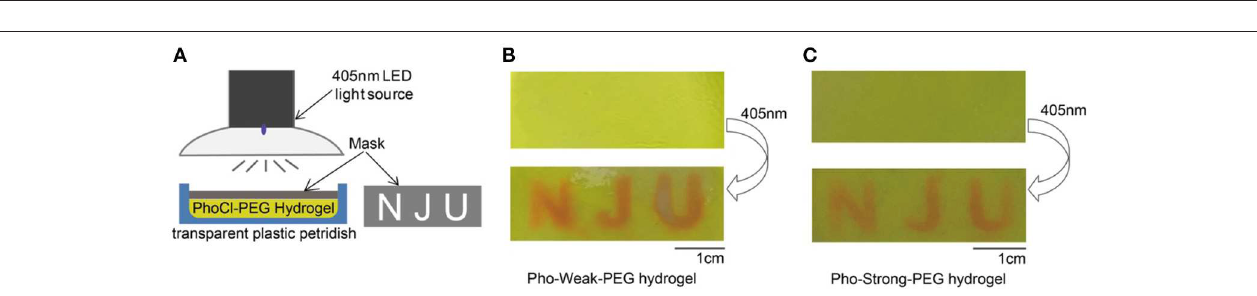
FIGURE 5 | Rheological properties and photo-conversion of PhoCl-PEG hydrogels. (A) Frequency sweep of hydrogels with different Pho-Weak concentrations before and after photocleavage. (B) Real-time monitoring the photo-weakening of hydrogel by rheology (Frequency: 1Hz). (C) Optical photographs of Pho-Weak-PEG hydrogels: pristine (left, gel) and after photo illumination (right, viscous liquid). (D) Frequency sweep of hydrogel with different Pho-Strong concentrations before and after photocleavage. (E) Real-time monitoring the photo-weakening of hydrogel by rheology (Frequency: 1Hz). (F) Optical photographs of Pho-Strong-PEG hydrogels: pristine (left) and after photo illumination (right). The legend next to (B) applies to (A, B, D, E) .